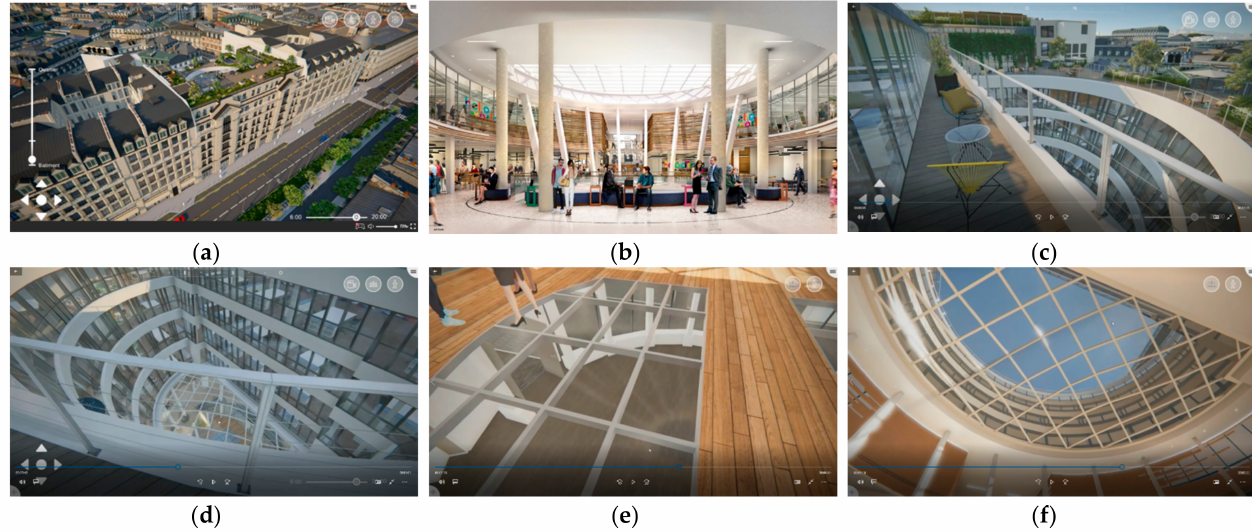
Figure 7. Selection of screenshot frames from the pre-recorded VR video clip inspired by the case-study palace in Paris, FR (adapted from [45], © Generali Real Estate French Branch): ( a ) general view of the building (from Rue R é aumur); ( b ) indoor open space; ( c ) top terrace; ( d ) glass conical envelope/facade; ( e ) glass floor (from the ground level); ( f ) glass roof (from the ground